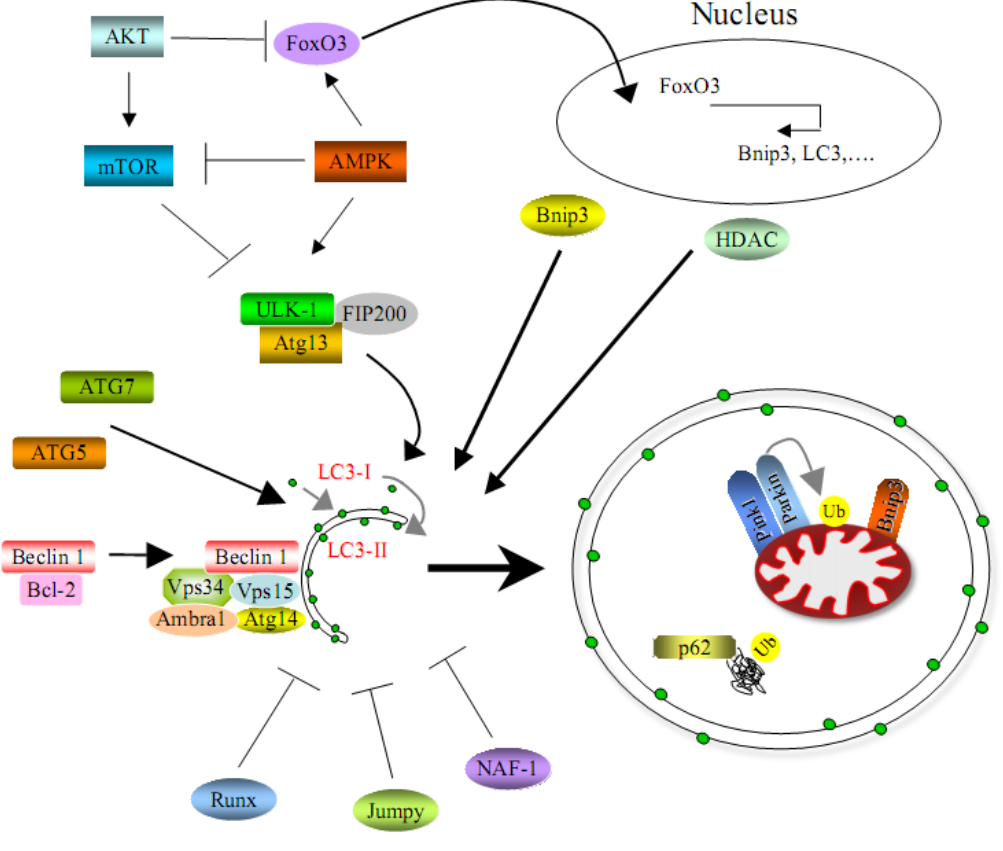
Figure 2. Scheme that represents positive and negative regulators of autophagy in skeletal